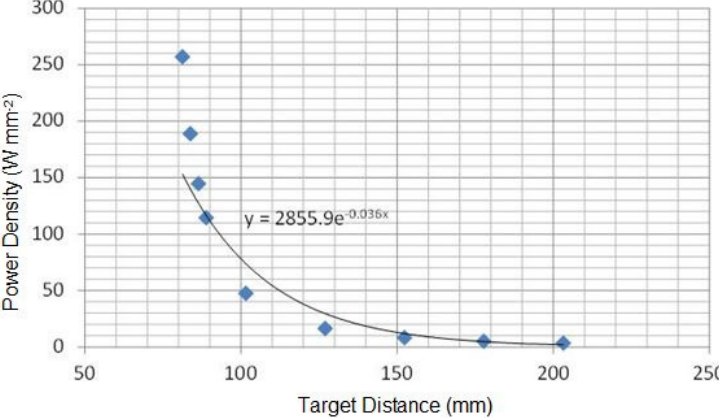
Figure 6. Experimental micro ‐ controller based CNC CO 2 laser treatment system designed to provide precise control over the laser treatment time and energy precise control over the laser treatment time and energy density.